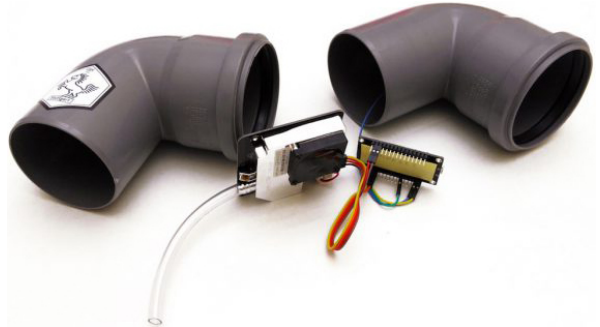
Figure 1. PM sensor